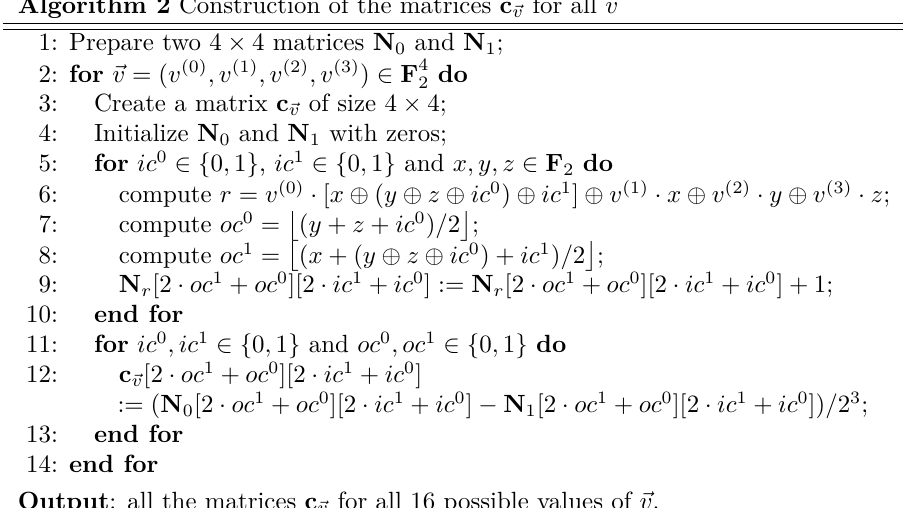
Algorithm 2 Construction of the matrices c ~v for all